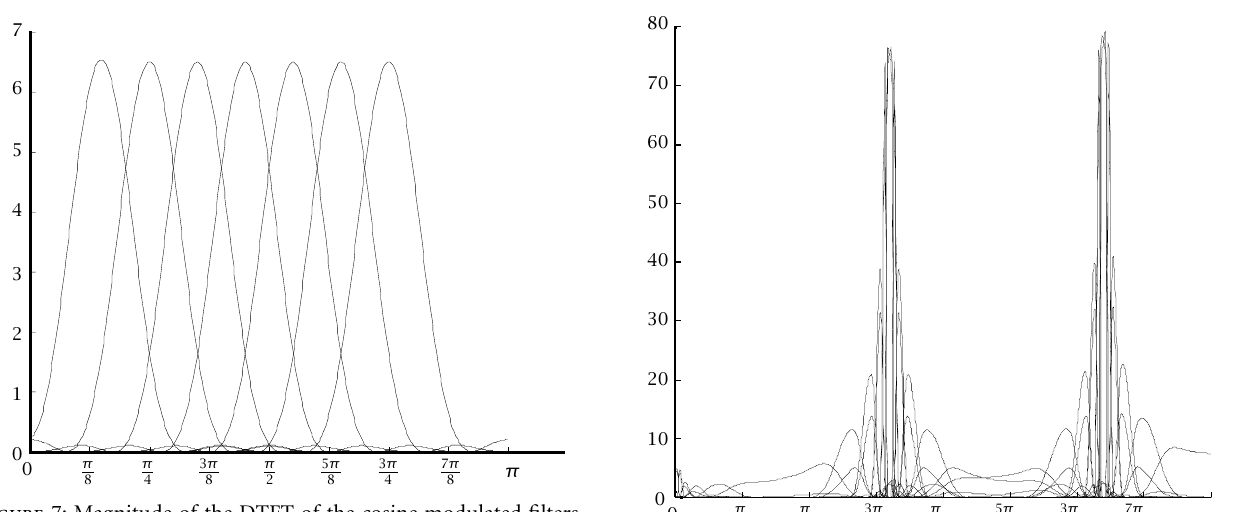
Figure 7: Magnitude of the DTFT of the cosine modulated filters ( 28 ) .